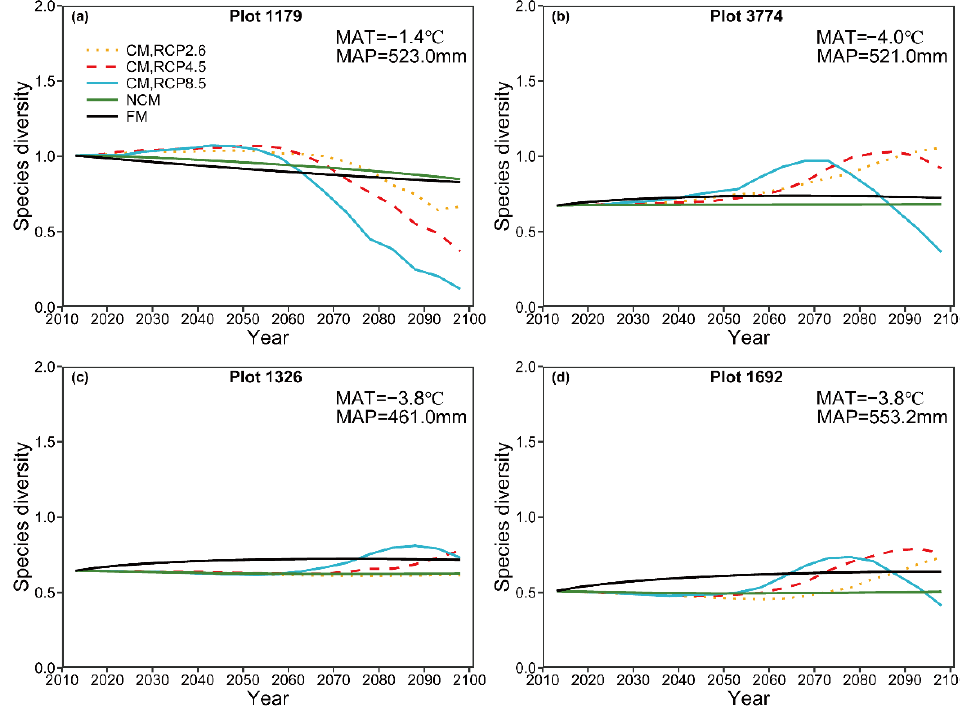
Figure 8. Long-term prediction of species diversity by the climate-sensitive model (CM) under three RCPs, the variable transition model which did not expect climate change (NCM), and the fixed-parameter model (FM), using NFI plots 1179, 3774, 1326, and 1692. The value of the MAT is the mean annual temperature between 2013 and 2018 and MAP represents the mean annual precipitation of the same period.